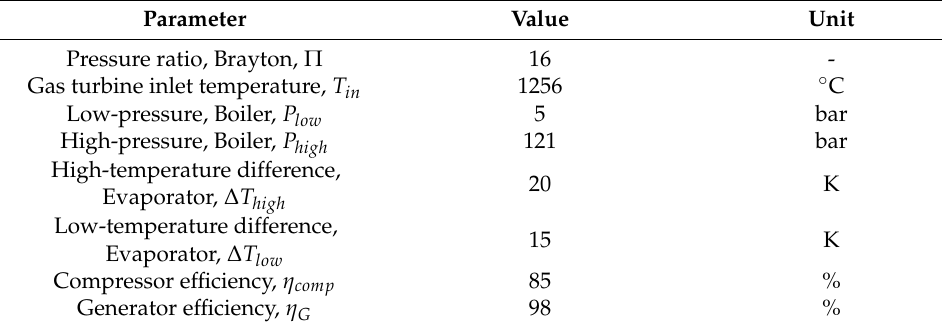
Table 6. Boundary conditions of the power